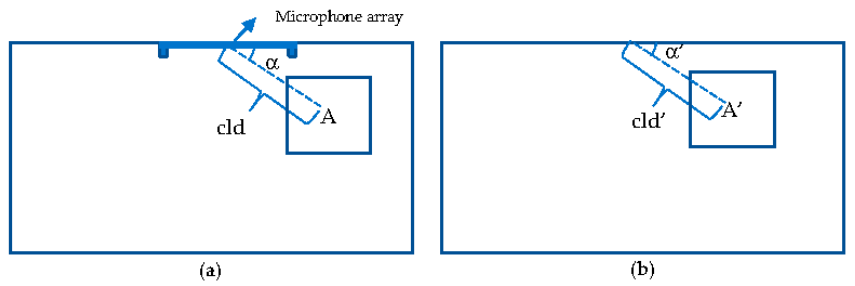
Figure 3. Determine initialization area: ( a ) Large display; ( b ) a working area on a flat surface for the mobile device.